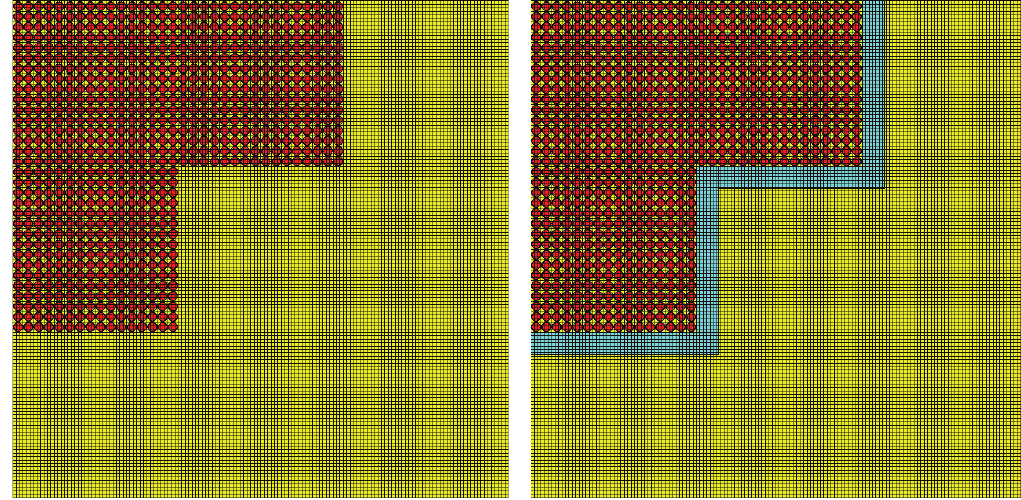
Figure 5: 1/4 plan view of grid mesh in NEWT 2D model.